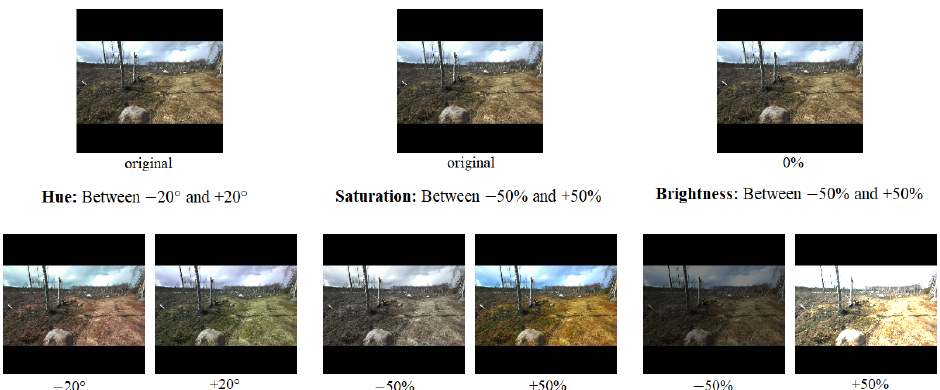
Figure 5. Samples of augmentation methods: hue (left), saturation (middle) and brightness (right). Through augmentation, we expanded the image data set for training from 197 to 591 images.